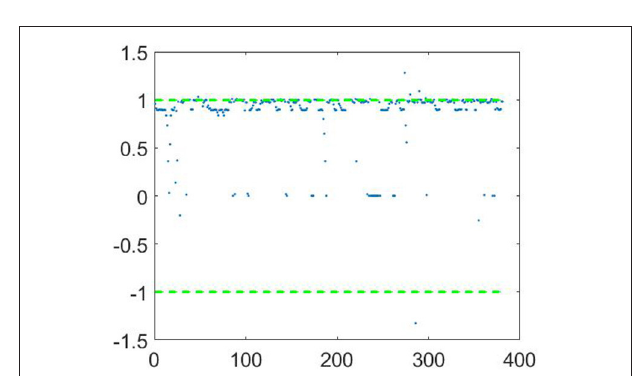
calculated. It is necessary to use such parameters that provide distinct description of male and female voices. We used two- dimensional ( d = 2) parameters vector consisting of pitch period T 0 [22] and difference of the first two line spectral frequencies (LSF) d = ω 2 − ω 1 [for the definition, properties and computation of line spectral frequencies, see e.g.,